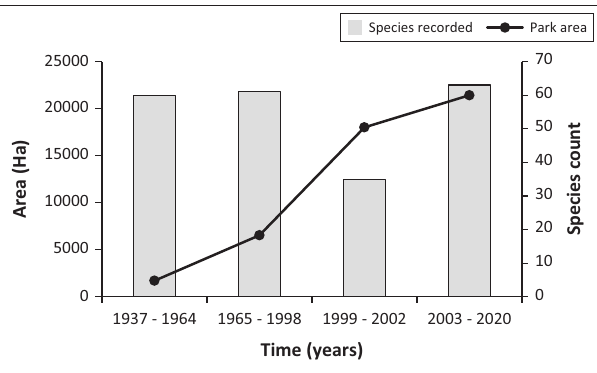
FIGURE 2 : The four periods of park expansion for the Mountain Zebra National Park, Eastern Cape, South Africa between 1937 and 2020. The total number of mammal species recorded during each period (grey bars) is also shown. The solid line denotes the cumulative increase in park area (hectares) over